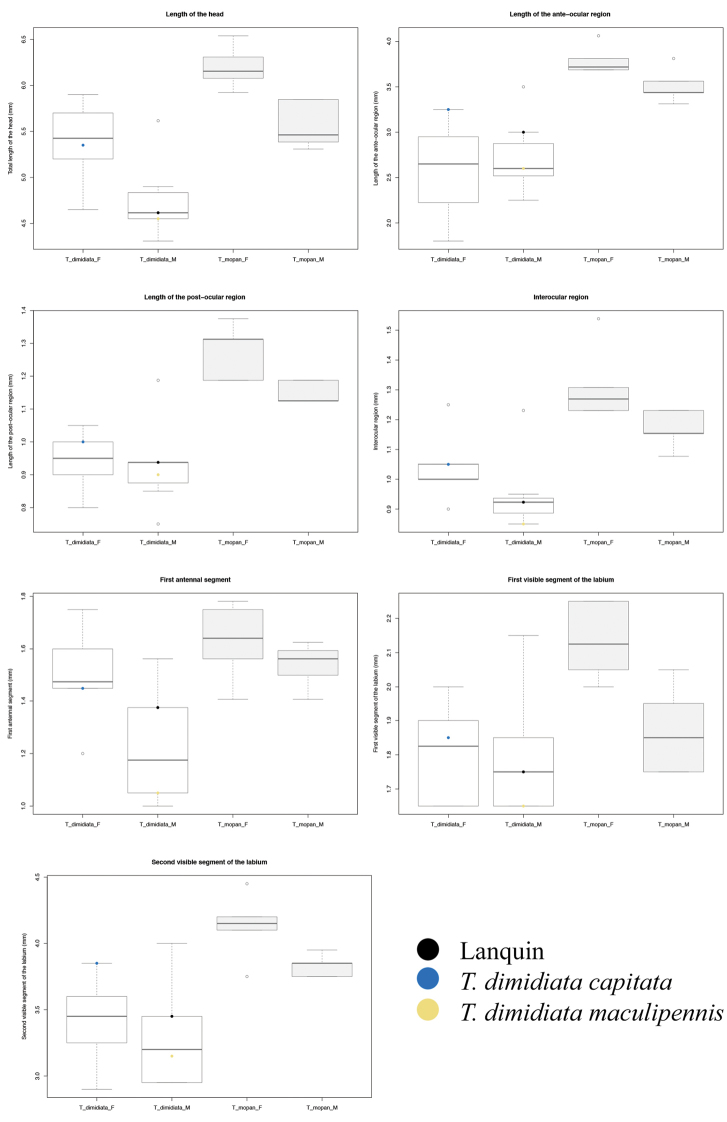
Barplot of the character measures that were significantly different for at least one comparison between male and females of T.
mopan and T.
dimidiata (see Table 3).